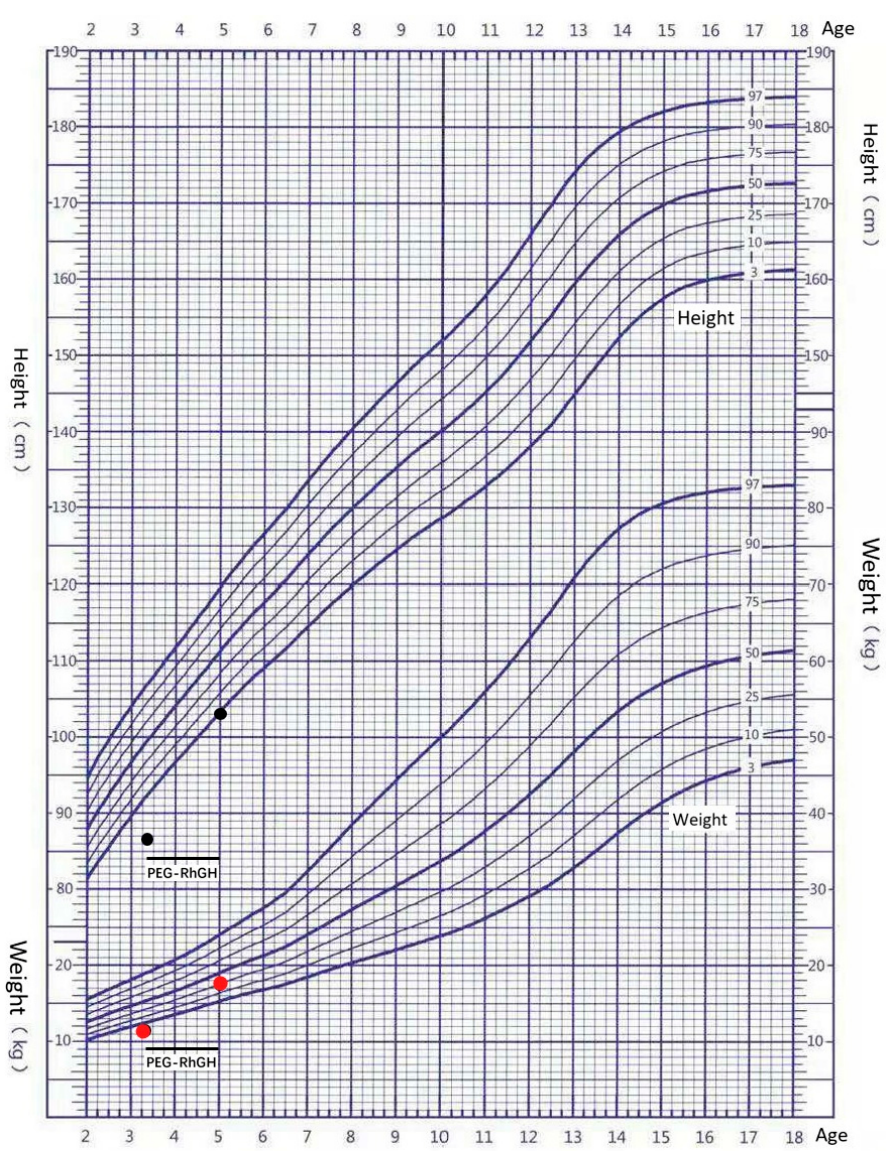
Figure 2. Growth curve of boys aged 2–18 years in China. The black dots represent changes in height after (PEG-rhGH) treatment. The red dots represent changes in weight after (PEG-rhGH)